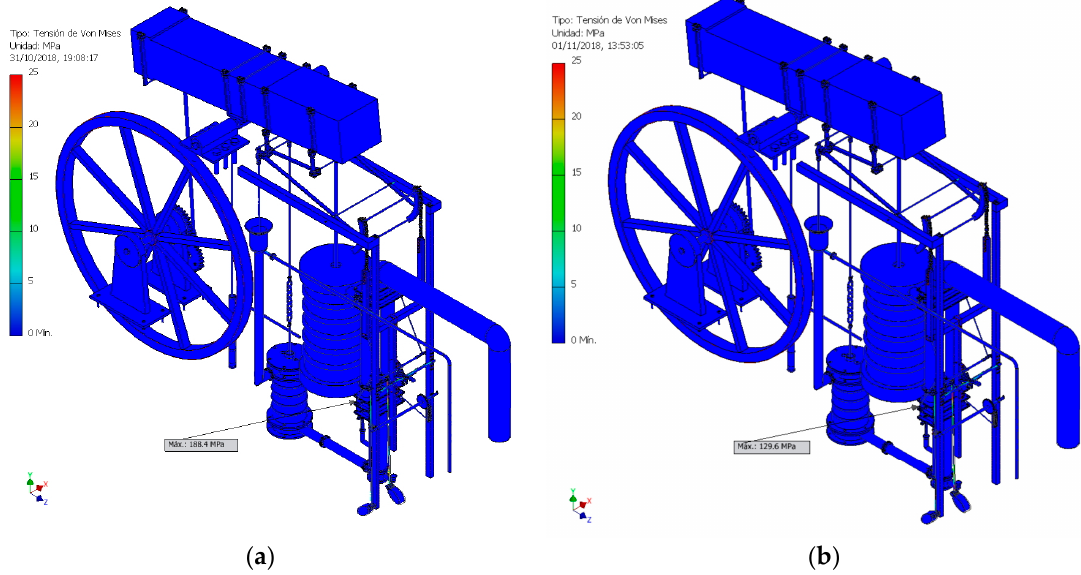
Figure 14. Von Mises stress distribution: ( a ) downward movement and ( b ) upward movement.